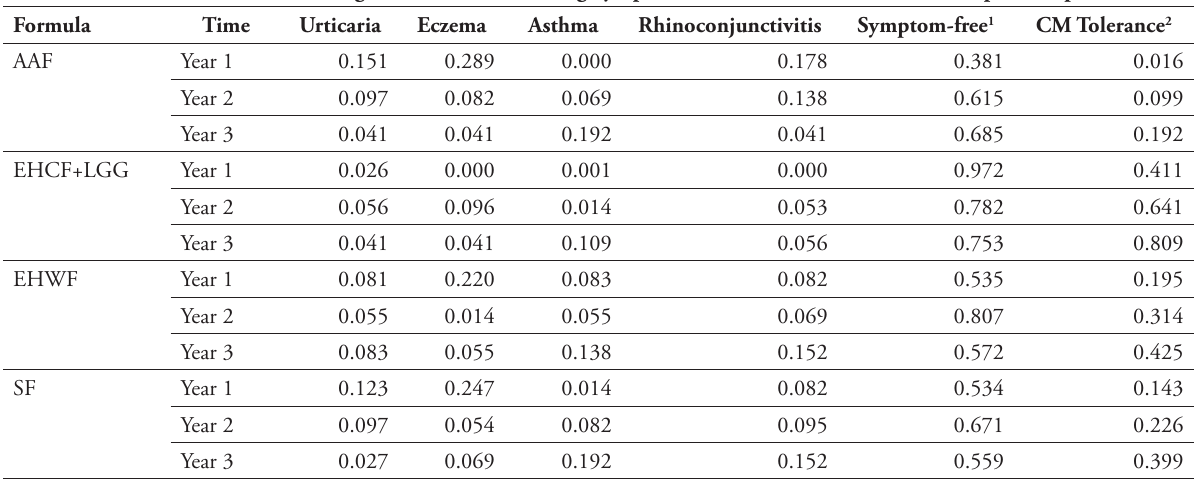
Table 1. Annual Probabilities of Allergic Manifestations, Being Symptom-free and Tolerant to Cow’s Milk per Comparator